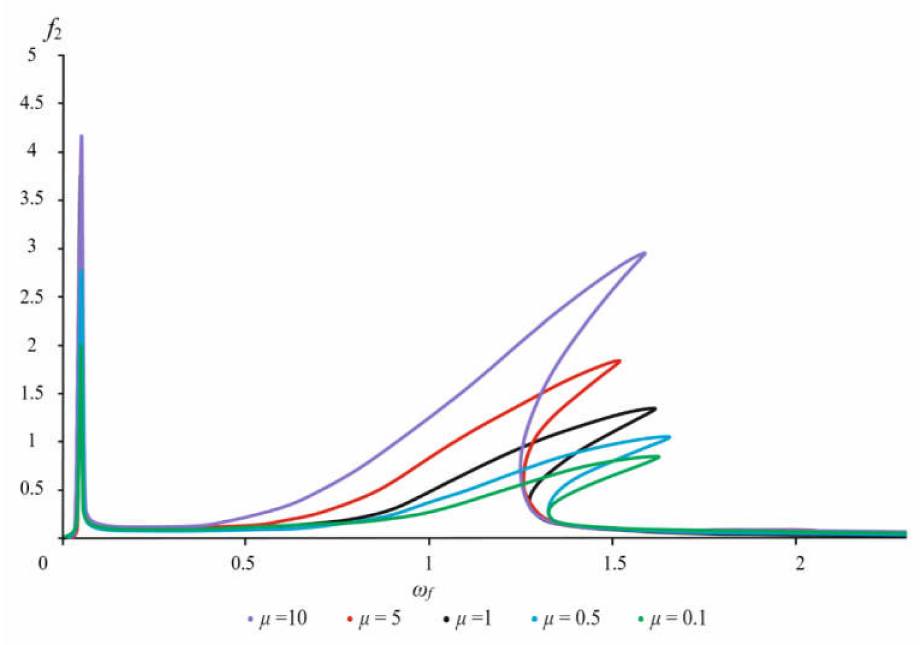
Figure 10. The amplitude-frequency characteristic of the foundation for different mass ratios. When varying the linear stiffness coefficient λ , both a change in the magnitude of the amplitudes and their shift along the frequency axis are observed. With an increase in the coefficient c 0 (Figures 11 and 12: cases λ = 0.1 and λ = 0.5), the first and second resonant frequency regions shift to the left along the frequency axis, towards its decrease. In the case when λ = 0.5, the first region of resonant frequencies shifts to the value of ω f = 0.04, while the drop in amplitudes characteristic of the second region of resonant frequencies is already observed at ω f = 1.25. With a further decrease in the linear stiffness parameter, i.e., at λ = 0.1, the first resonant region already sets in at ω f = 0.035, and the drop in amplitudes is already observed at ω f = 1.15. As the stiffness coefficient c 0 decreases, the reverse picture is observed. For example, at λ = 5, the first region of resonant frequencies shifts in